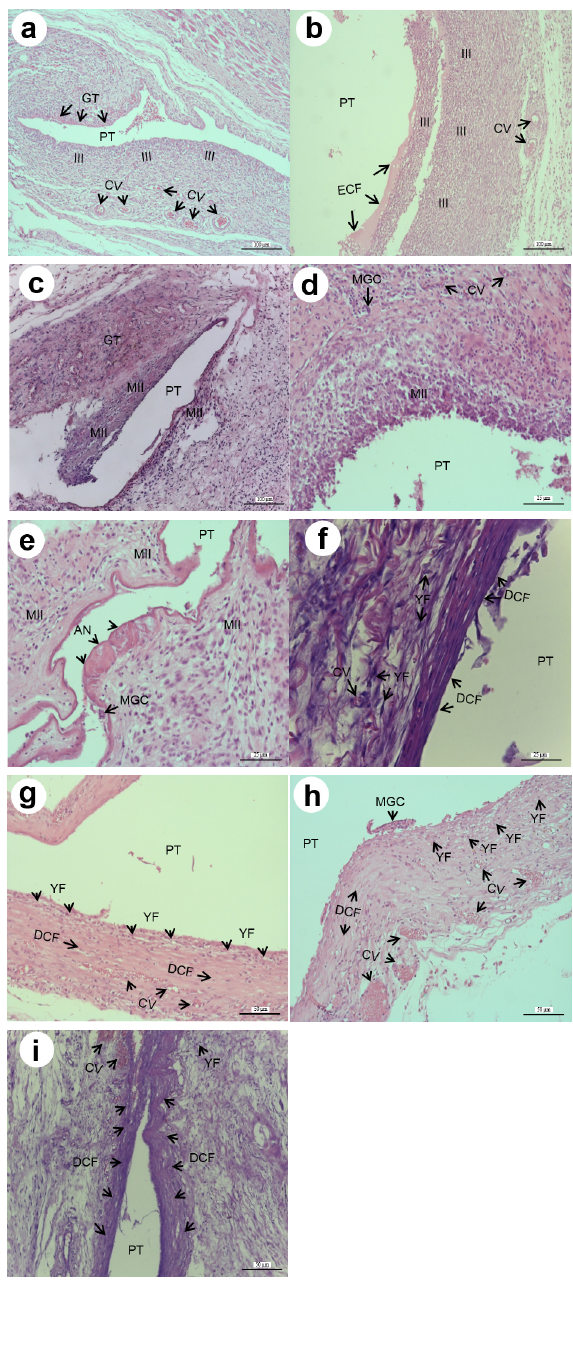
Figure 1. Photomicrographs of histological